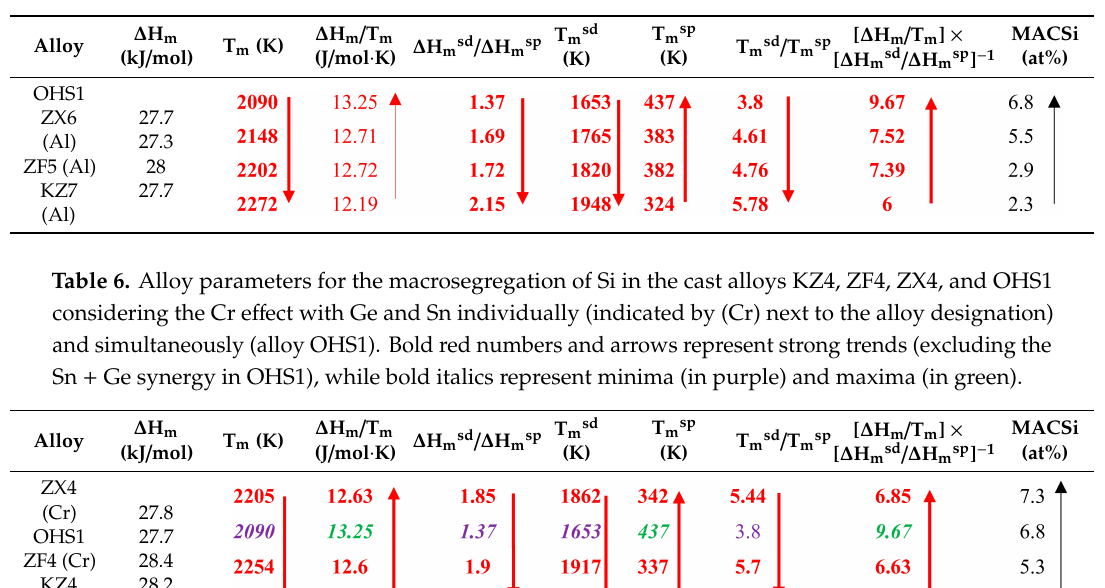
Table 5. Alloy parameters for the macrosegregation of Si in the cast alloys KZ7, ZF5, ZX6, and OHS1 considering the Al e ff ect with Ge or Sn individually and simultaneously. Bold red numbers and arrows represent strong trends, while non-bold red numbers and arrows represent weak trends.